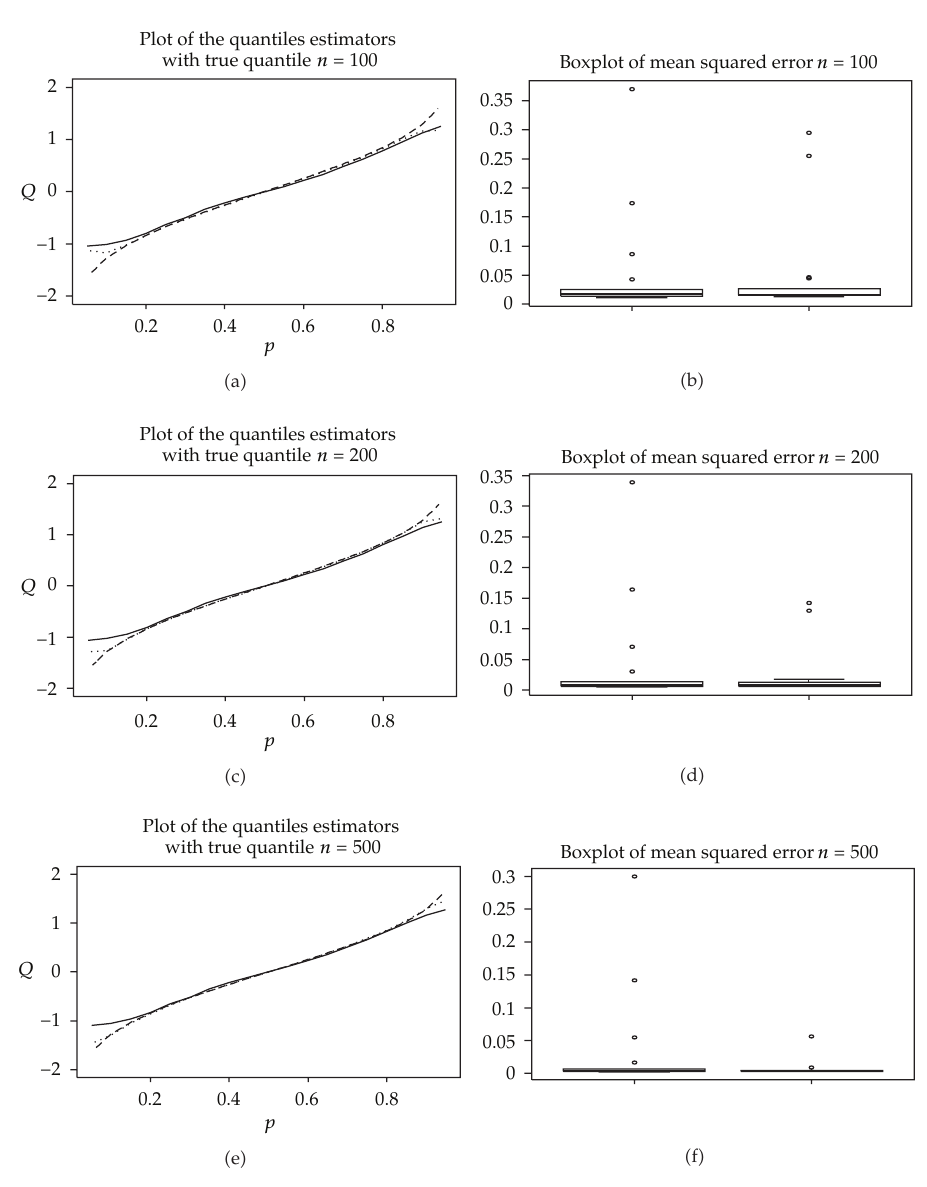
Figure 1: Left panel: plots of the quantile estimators for method 1 (cid:4) solid line (cid:5) , method 2 (cid:4) dotted line (cid:5) , and true quantile (cid:4) dashed line (cid:5) for di ff erent sample sizes and for data from a normal distribution. Right panel: box plots of mean squared errors for the quantile estimators for method 1 and method 2 for di ff erent sample